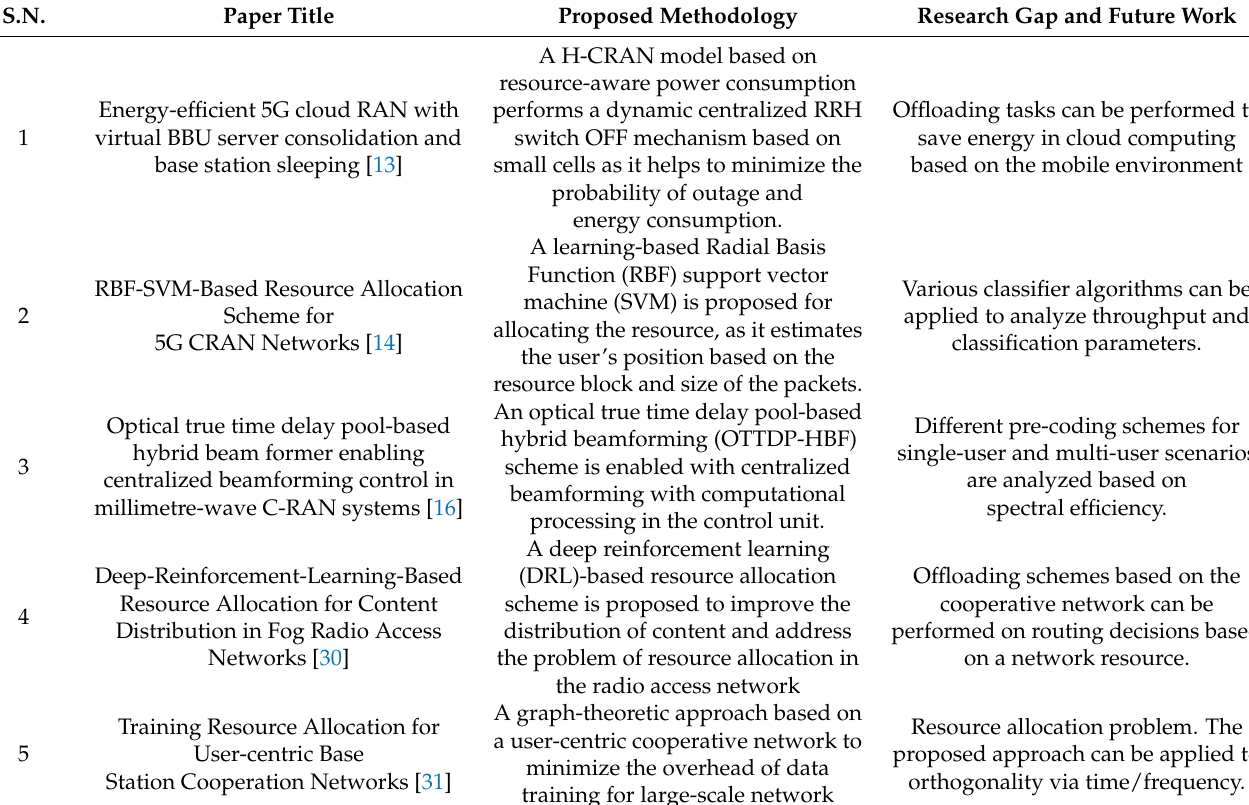
Table 1. Existing works based on resource